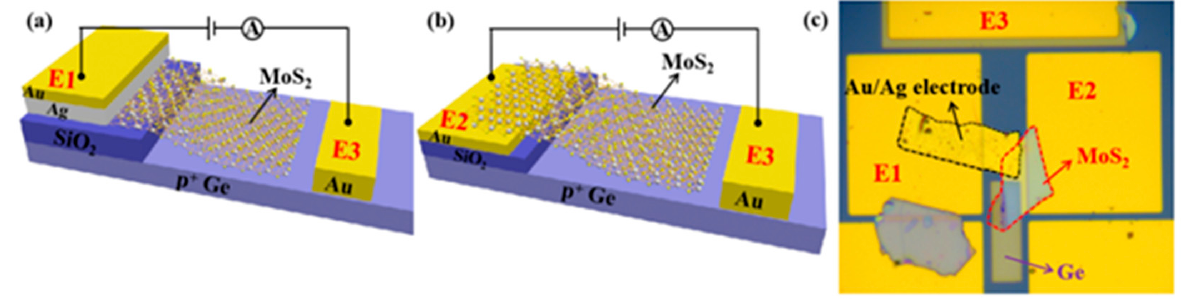
Figure 25. Schematic diagram of MoS2/Ge heterojunction with ( a ) Ag electrode, ( b ) Au electrode, and ( c ) optical image of MoS2/Ge heterojunction. Reproduced from [82], Optica Publishing, open access, 2022.